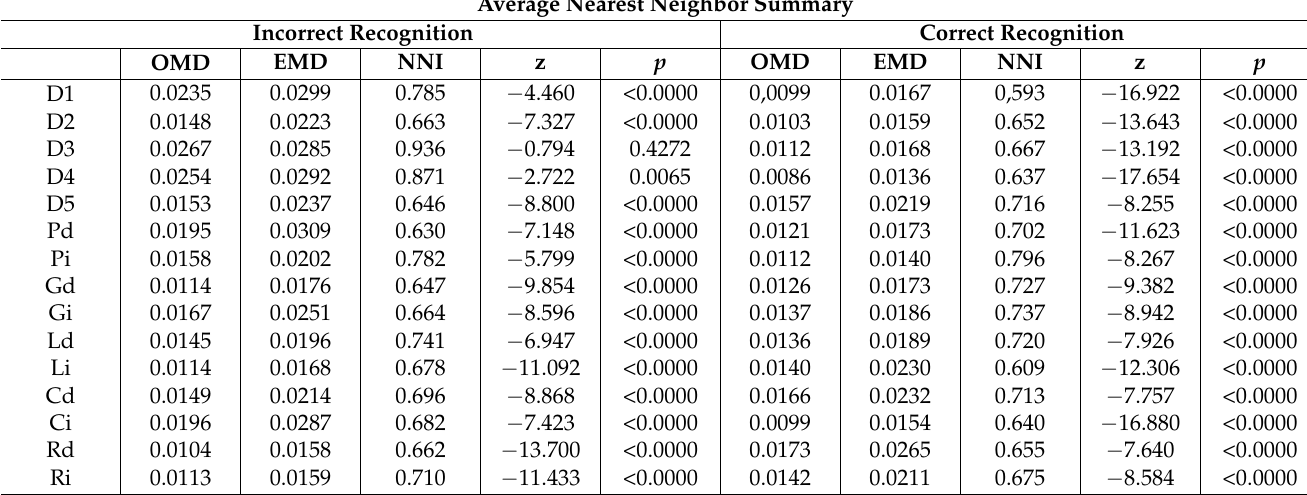
Table 1. Average Nearest Neighbor Summary of the fixation distribution of participants’ correct and incorrect